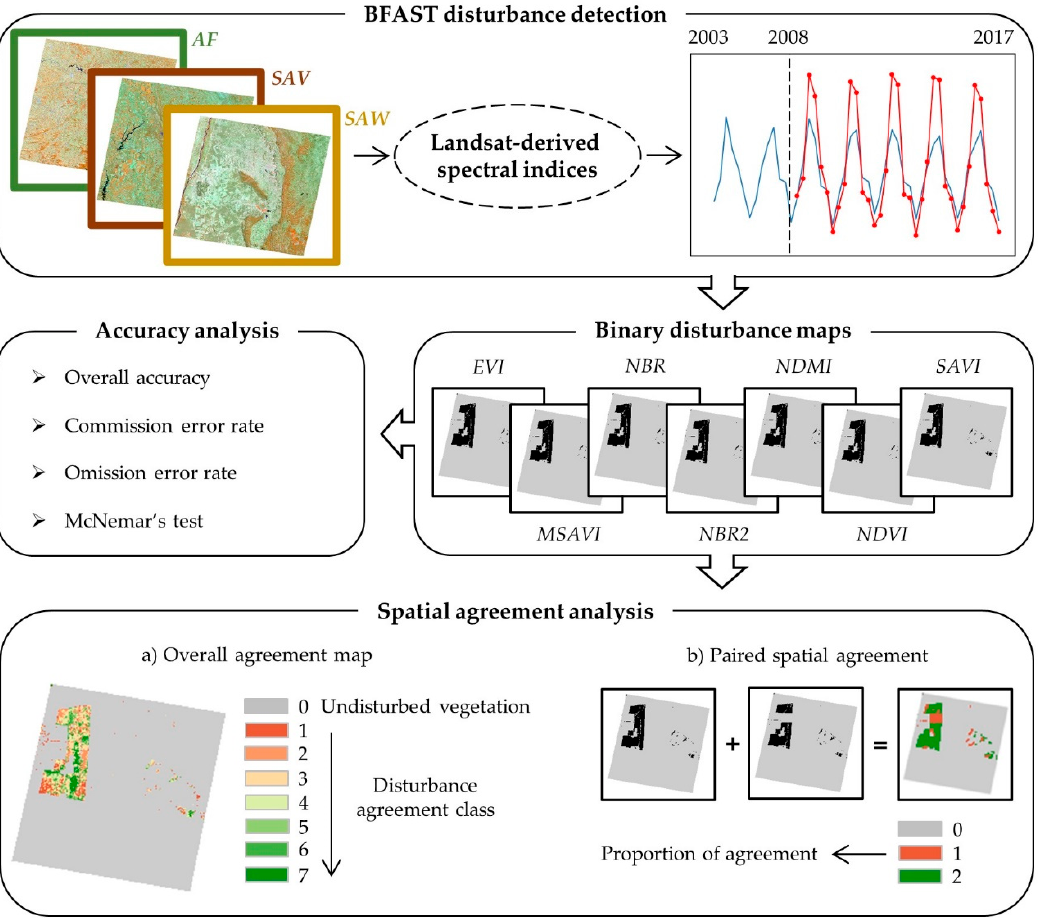
Figure 2. Schematic illustrating the data agreement analysis. Vegetation domains are represented by Atlantic forest (AF), savanna (SAV), and semi-arid woodland (SAW).